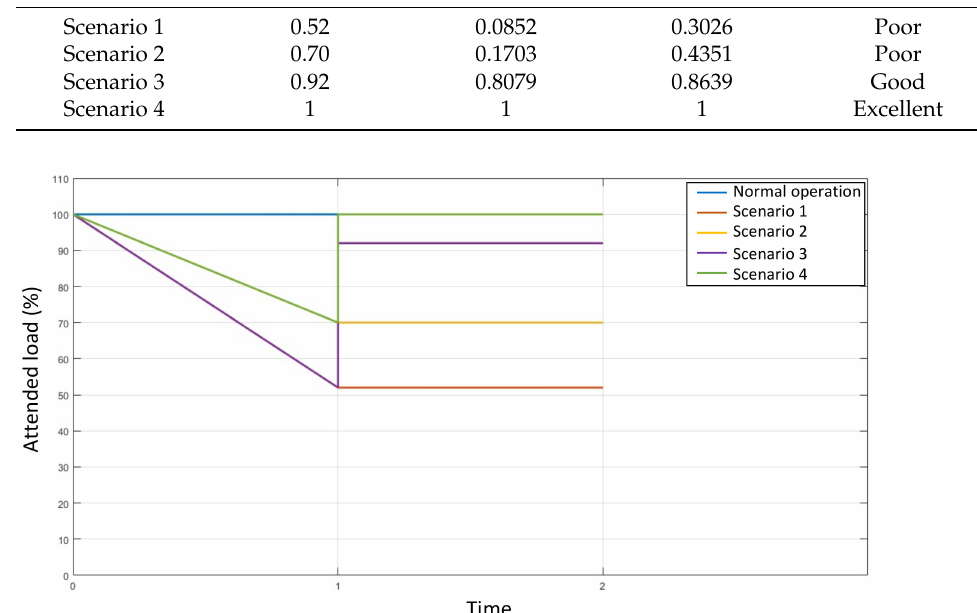
Figure 7. Served load in